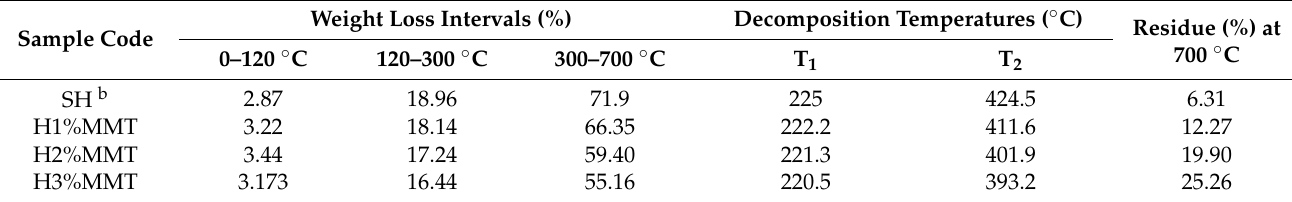
Table 6. The TGA/DTG results obtained for investigated composite hydrogels a . Sample